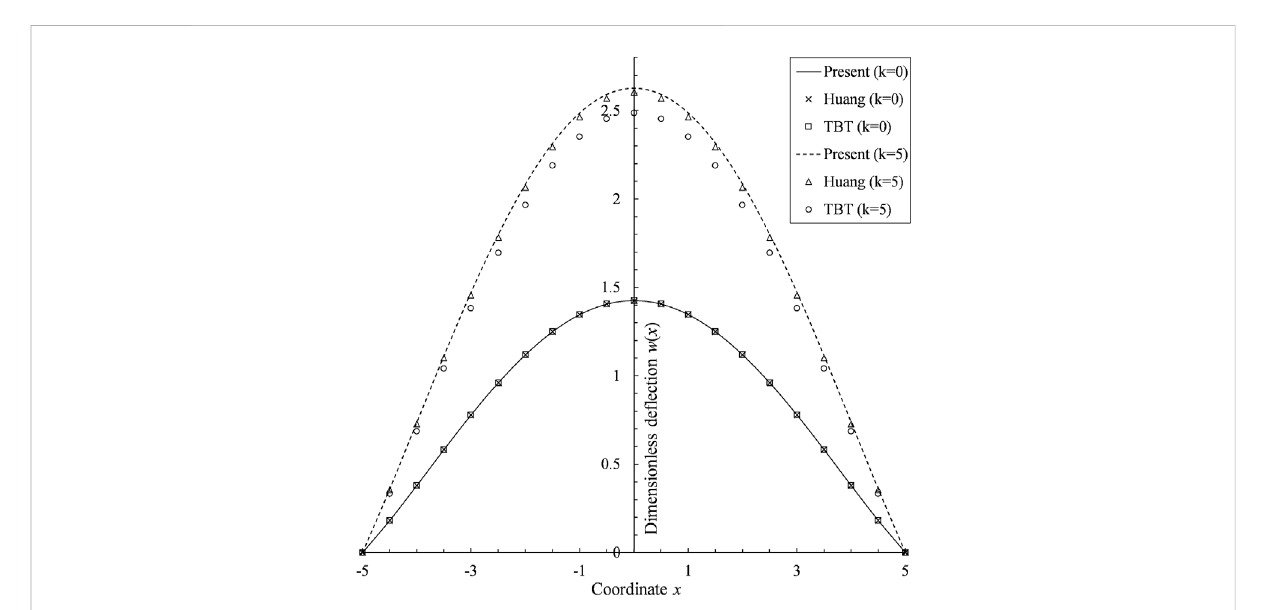
FIGURE 3 The comparison of the dimensionless de fl ections curves w ( x )* 100 E 1 R 3 / q 0 L 3